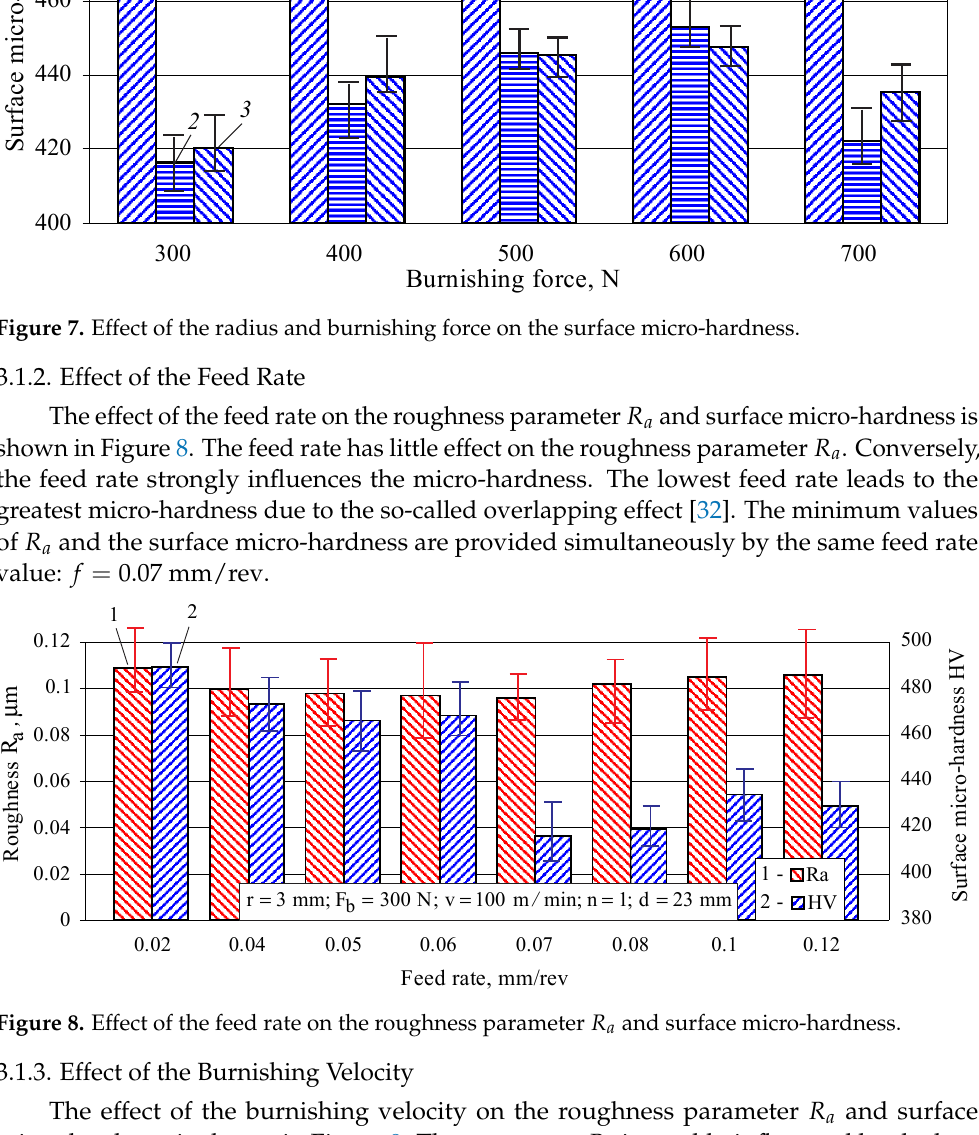
is weakly influenced by the bur- a R are